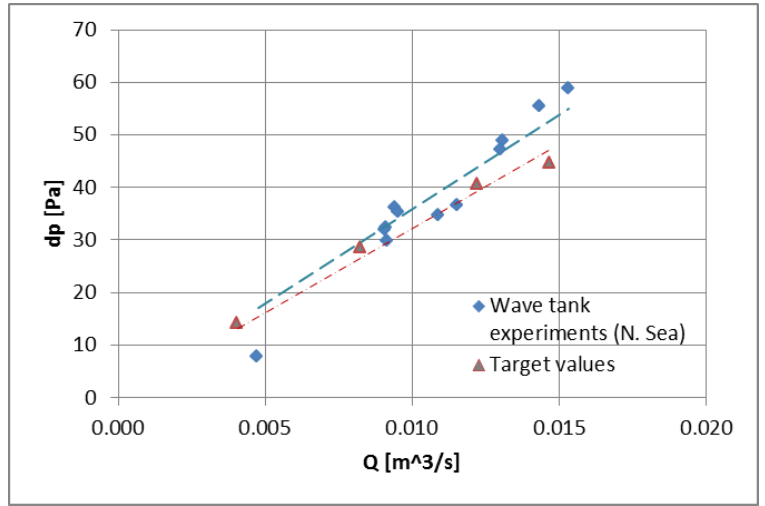
Figure 8. Performance of the porous diaphragms during wave tank experiments (model scale).